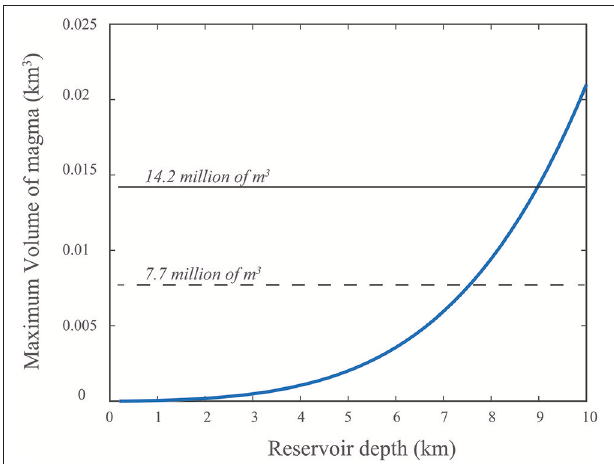
FIGURE 5 | Maximum volume of magma stored as a function of the magma reservoir depth. Estimation is made considering a Mogi source centered below the crater and using the fact that no vertical displacement larger than 1cm is observed from the crater toward a lateral distance of 4km. Volume estimations of deposits are represented for comparison as horizontal black lines (plain line for Reyes-Dávila et al., 2016, dashed line for Macorps et al.,